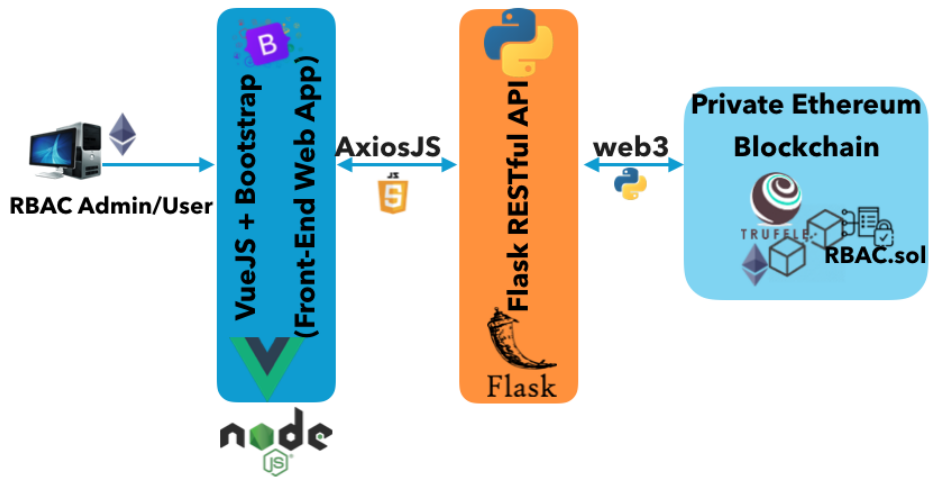
Figure 10. Decentralized RBAC